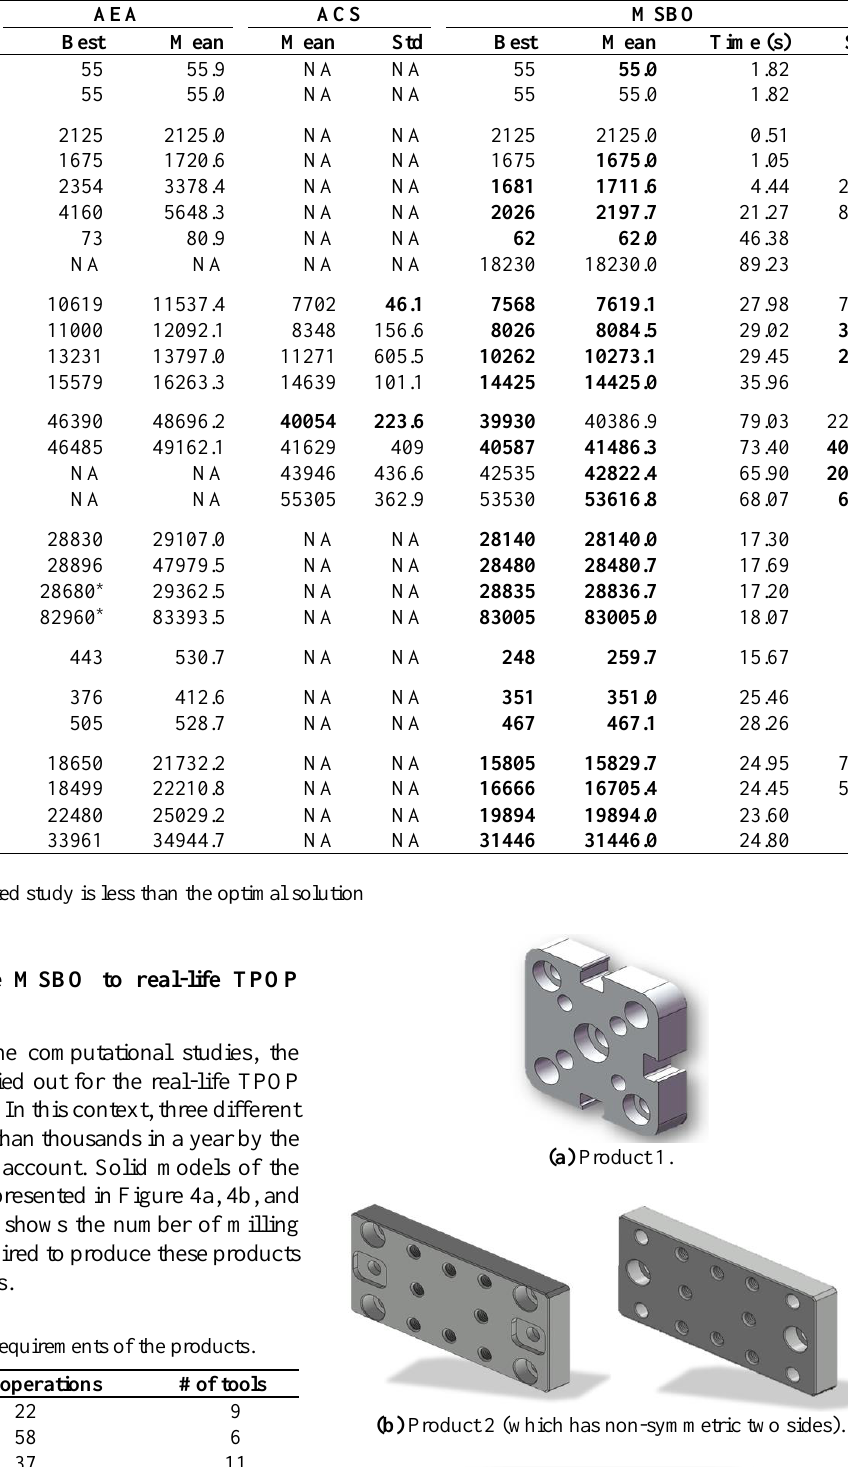
Table 4. Comparison of MSBO with AEA and ACS